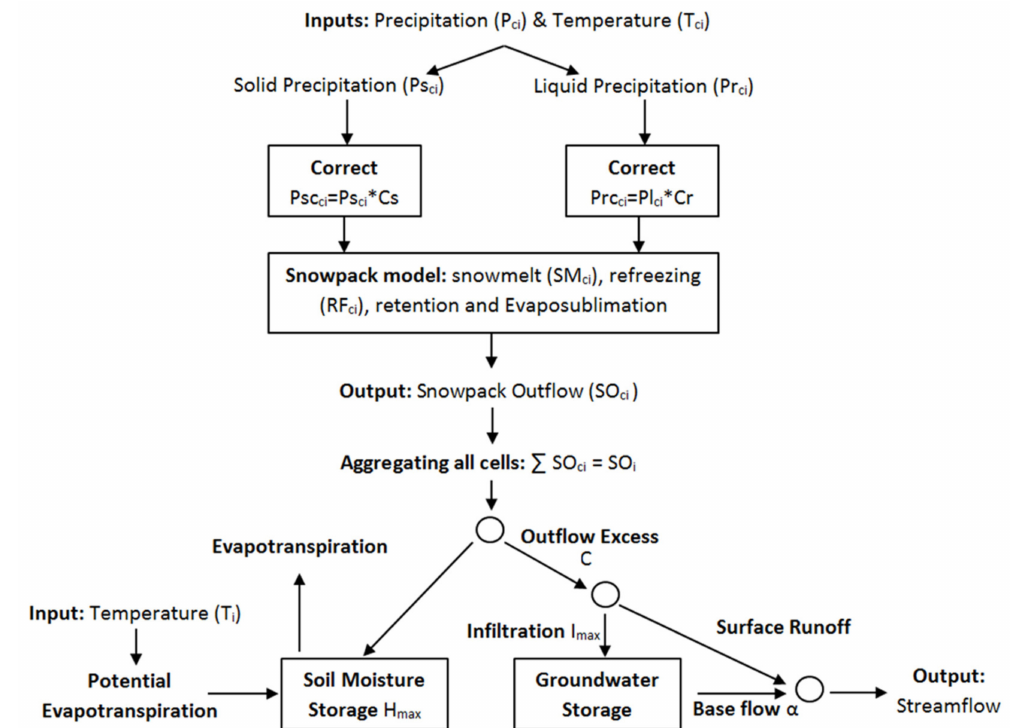
Figure 3. Schematic representation of the hybrid Snow-T é mez Model (STM), where the subscript c and i denote the variables associated with cell c for time i, Cr is the coe ffi cient for rainfall correction, Cs is the coe ffi cient for snowfall correction, H max is the maximum soil moisture capacity, C is the threshold to generate runo ff , I max is the maximum infiltration, and α is the discharge parameter for the aquifer. The parameter values are obtained by